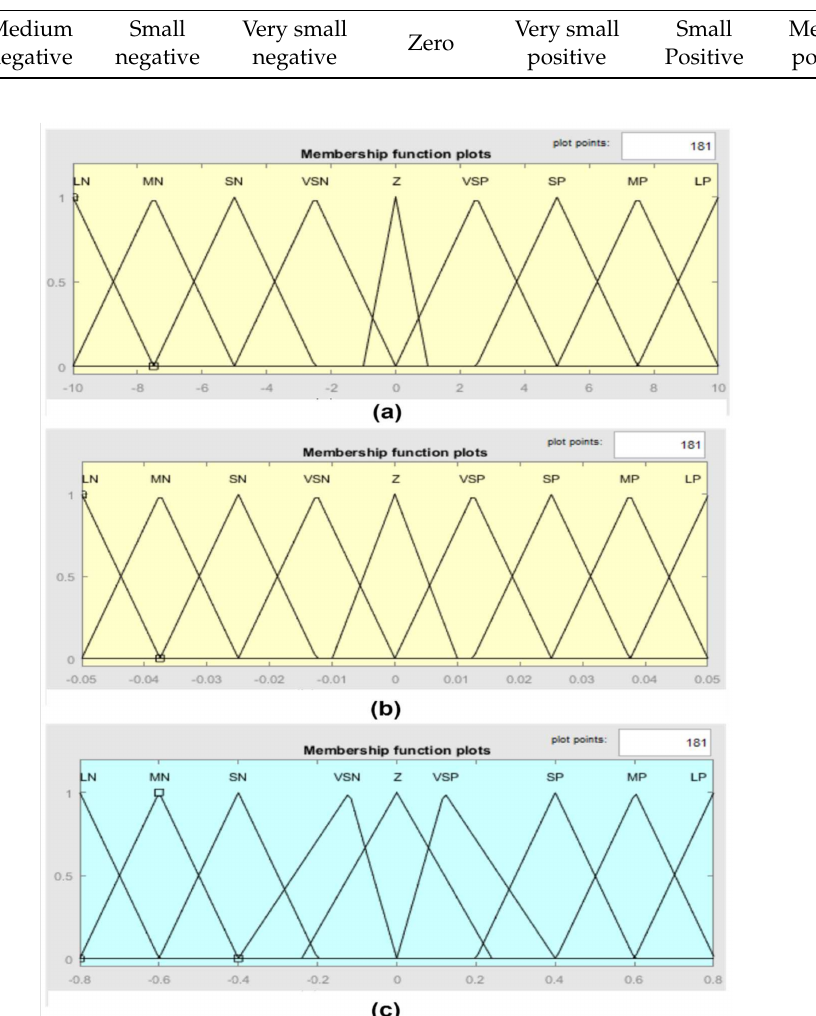
Figure 2. Membership function for the inputs and outputs; ( a ) input variable ( e ); ( b ) input variable ∆ ( e ) ; ( c ) output variable ( u PWM